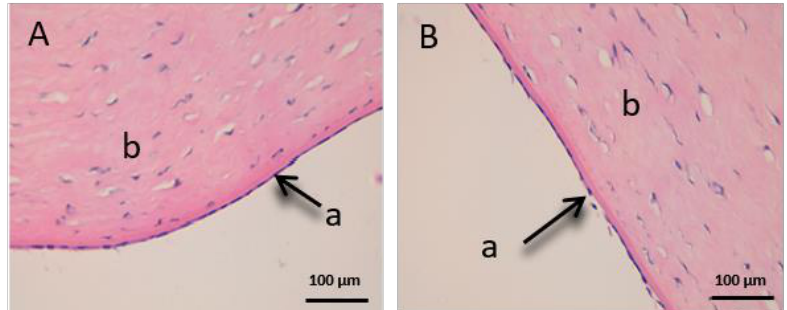
12 of 18 Figure 8. Histological images of sublingual mucous. ( A ): Untreated sublingual mucous observed at 400× and ( B ): Sublingual mucous treated with CP-Sat observed at 400×; a: stratified flat keratinized epithelium; b: own laminate; c: basal layer; d: muscle and e: collagen fibers. In Figure 9, we can see the cornea. It is a very fragile and fine fabric. The epithelium (a) and the lamina propria (b) are separated by a thin layer called Bowman’s membrane (c). Figure 9. Histological images of cornea. ( A ): Untreated cornea observed at 400× and ( B ): Cornea treated with CP-Sat observed at 400×. a: stratified flat keratinized epithelium; b: own laminate. c: Bowman’s membrane. Figure 10 shows the images of the conjunctiva. It is a highly vascular tissue and we can see hair follicles that belong to the eyelashes (d). Figure 10. Histological images of conjunctive mucous. ( A ): Untreated conjunctive mucous observed